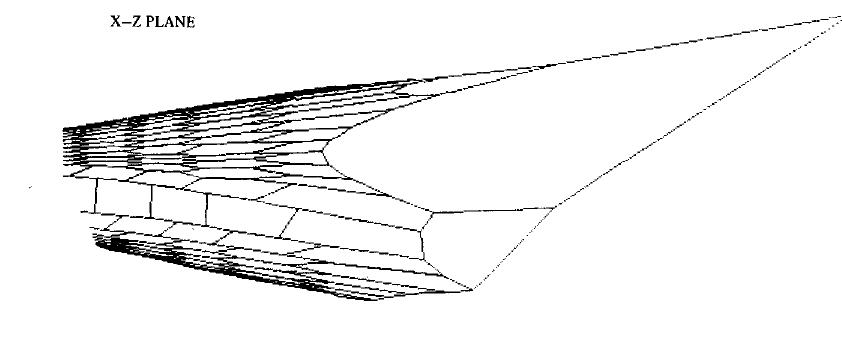
Fig. 7. Hanging shape of the front part of cable trawl, calculated by computer in 76 iteration